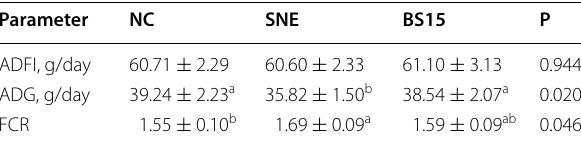
Table 4 Effects of Lactobacillus johnsonii BS15 on growth performance